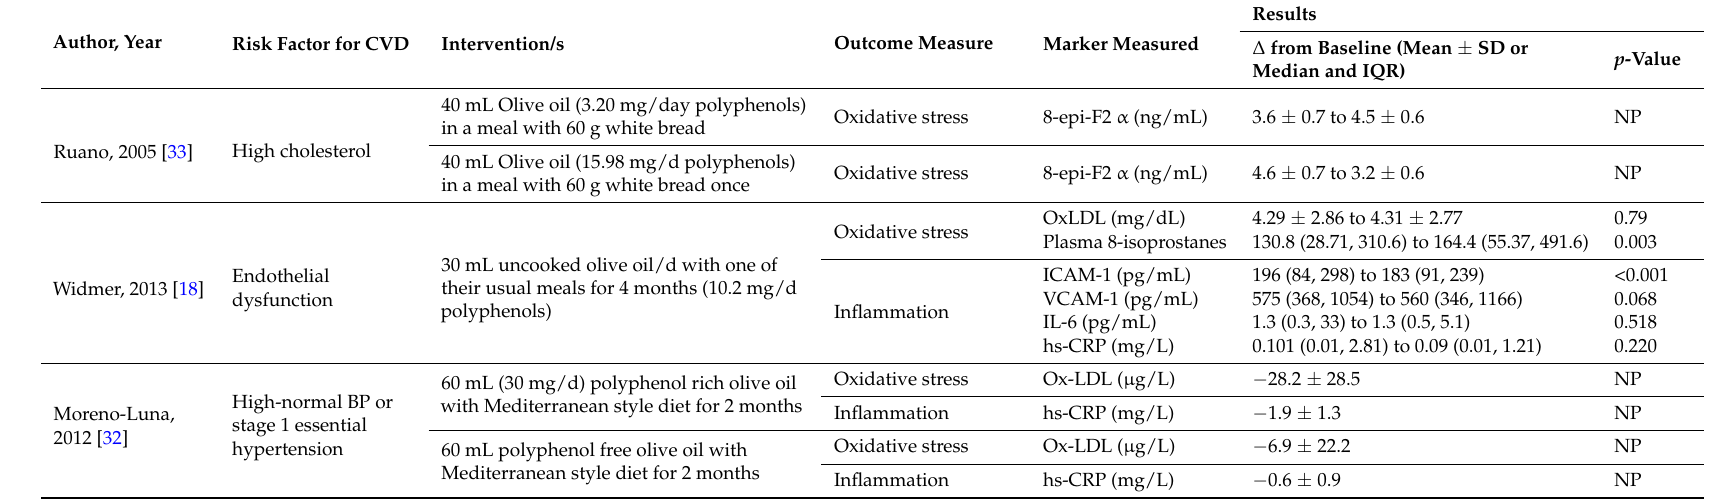
Table 10. Effect of olive oil polyphenols on oxidative stress and inflammation from baseline to